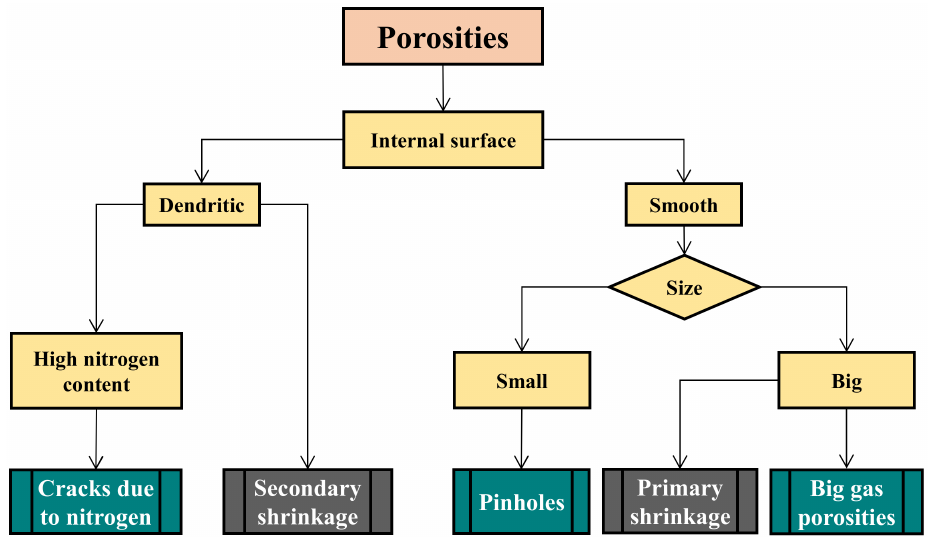
Figure 3. Classification of voids and porosities according to their internal surface